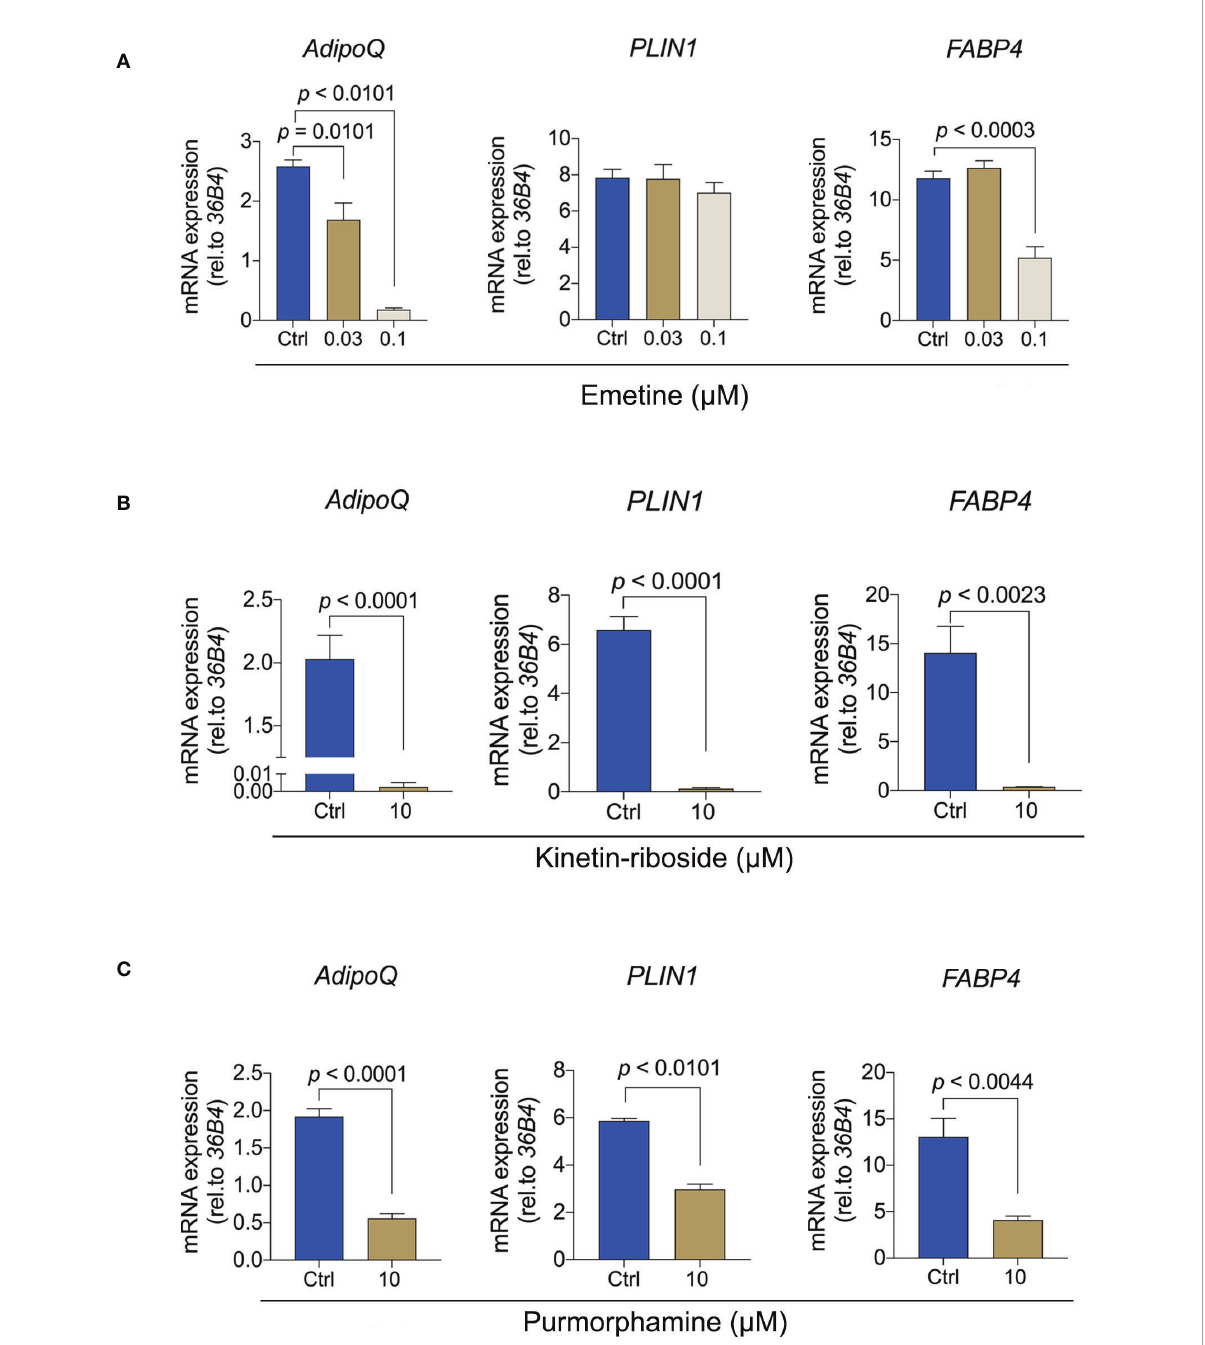
FIGURE 7 Emetine, kinetin-riboside and purmorphamine inhibit the expression of adipogenesis genes. (A-C) The expression of ADIPOQ , PLIN1 and FABP4 were evaluated after 7 days of adipogenic induction from BMSCs following treatment with emetine (A) , kinetin-riboside (B) and purmorphamine (C)